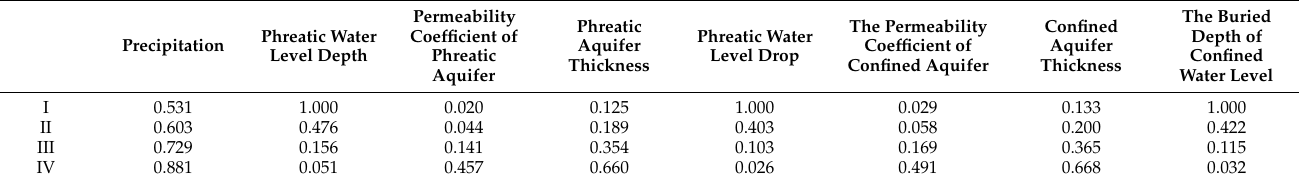
Table 3. Normalized results of the standard limit of groundwater carrying capacity evaluation